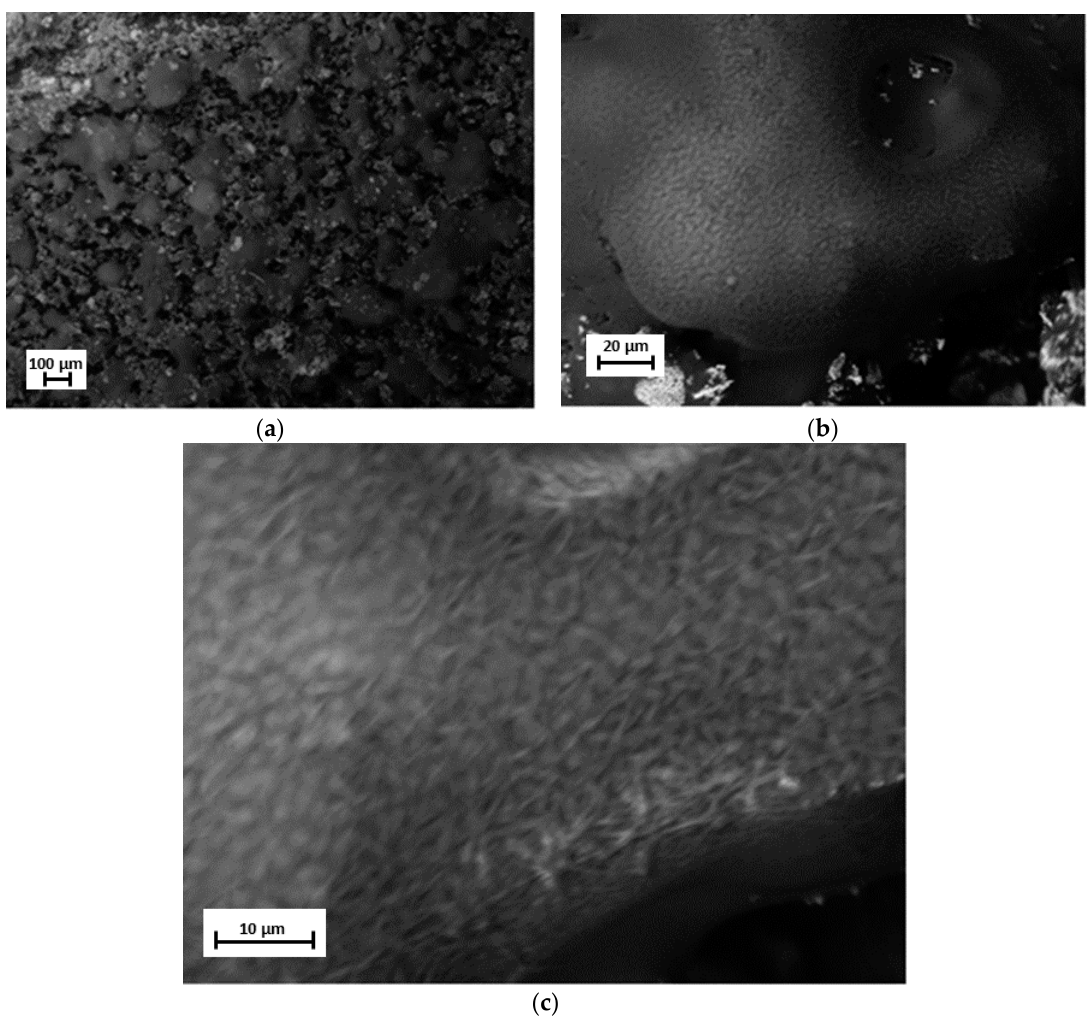
Figure 6. SEM micrographs of the film’s surface showing the nylon 11 fibers. ( a ) 150 x; ( b ) 1.55 Kx; ( c ) 4.04